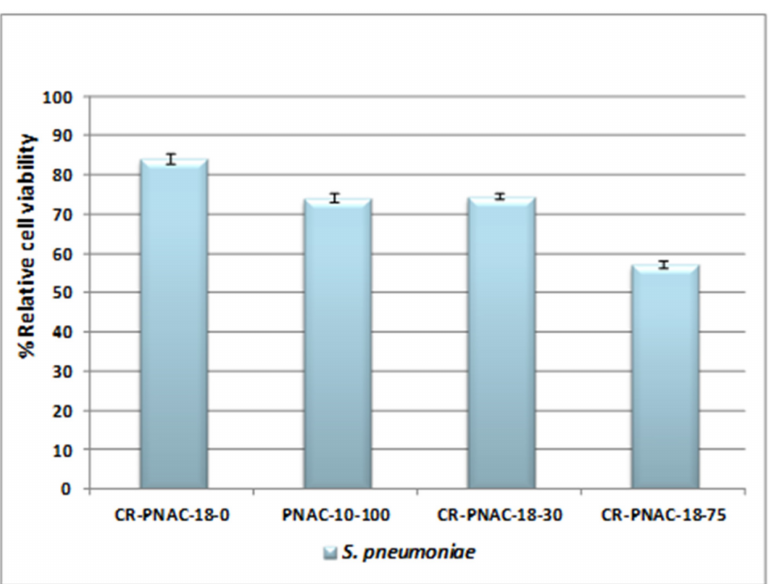
Figure 3. The antibacterial activity of the tested samples against S. pneumoniae CR-PNAC-18-0 control sample (without NAC and crosslinked with CoSH copolymer), PNAC-10-100, CR-PNAC-18-30, and